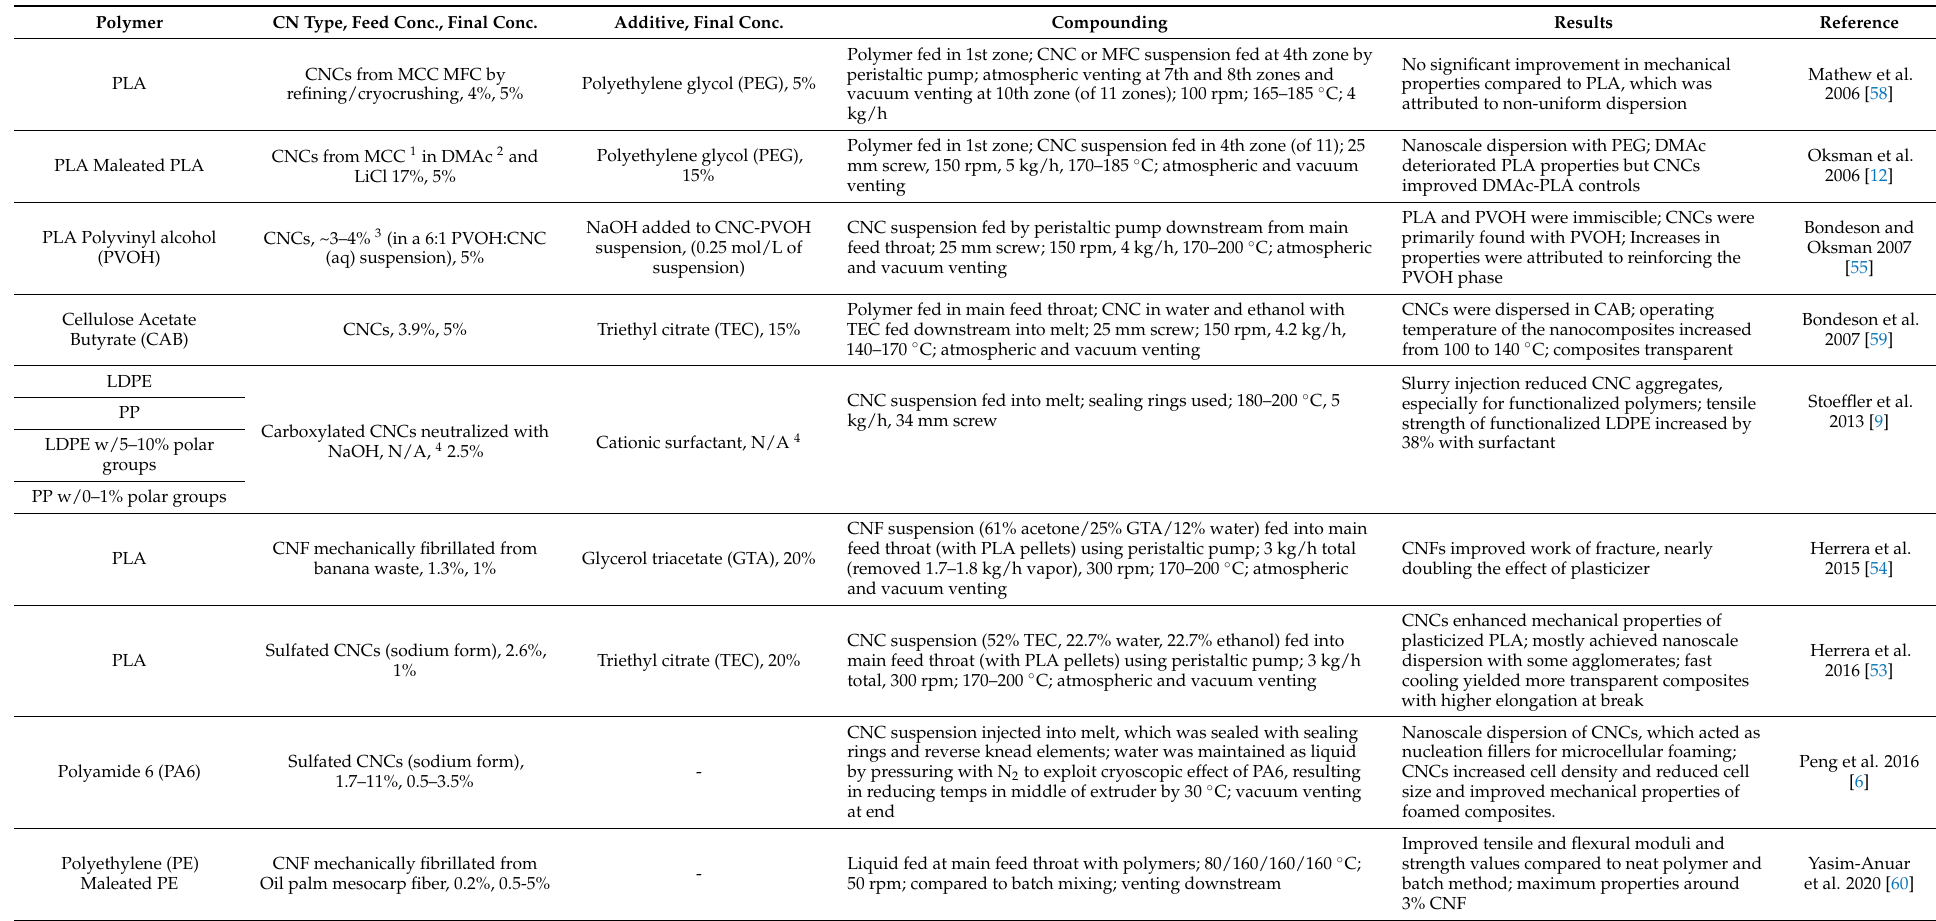
Table 2. Cellulose nanocomposites produced by liquid or gel feeding of cellulose nanomaterials (CNs) via wet extrusion